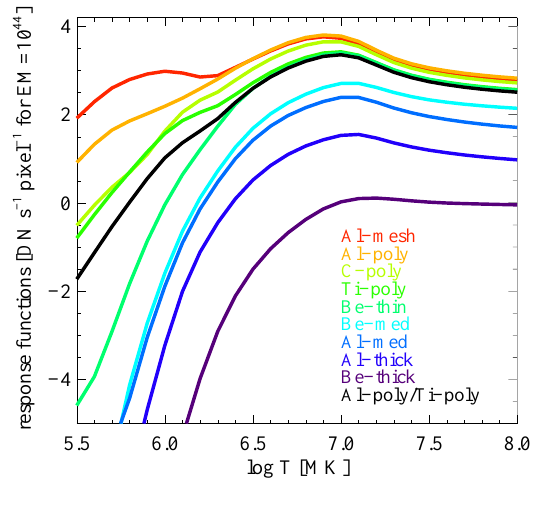
Fig. 1. Theoretical temperature response functions of the selected XRT